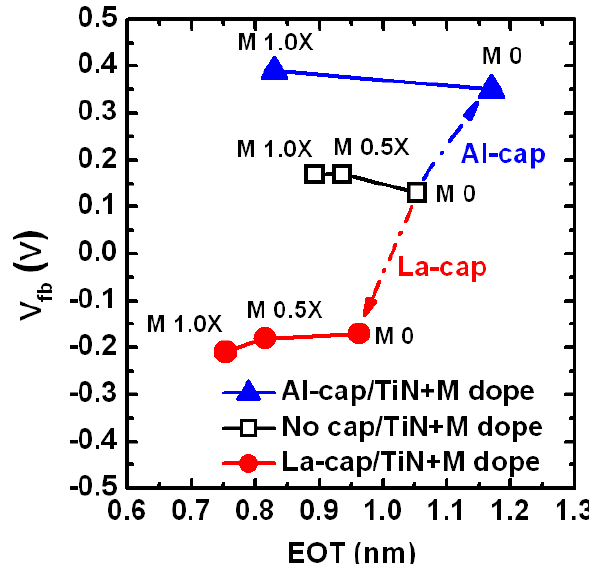
Figure 8. EOT-V plot for MOS capacitors prepared with process flow in Figure 7. The V fb values were tuned toward a negative (positive) direction using La-(Al-) caps. The EOT values were controlled by changing the amount of scavenging metal (M) dose in the TiN